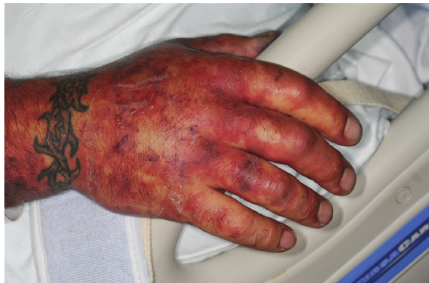
Figure 3: Ecchymotic nonblanching macular lesions on the